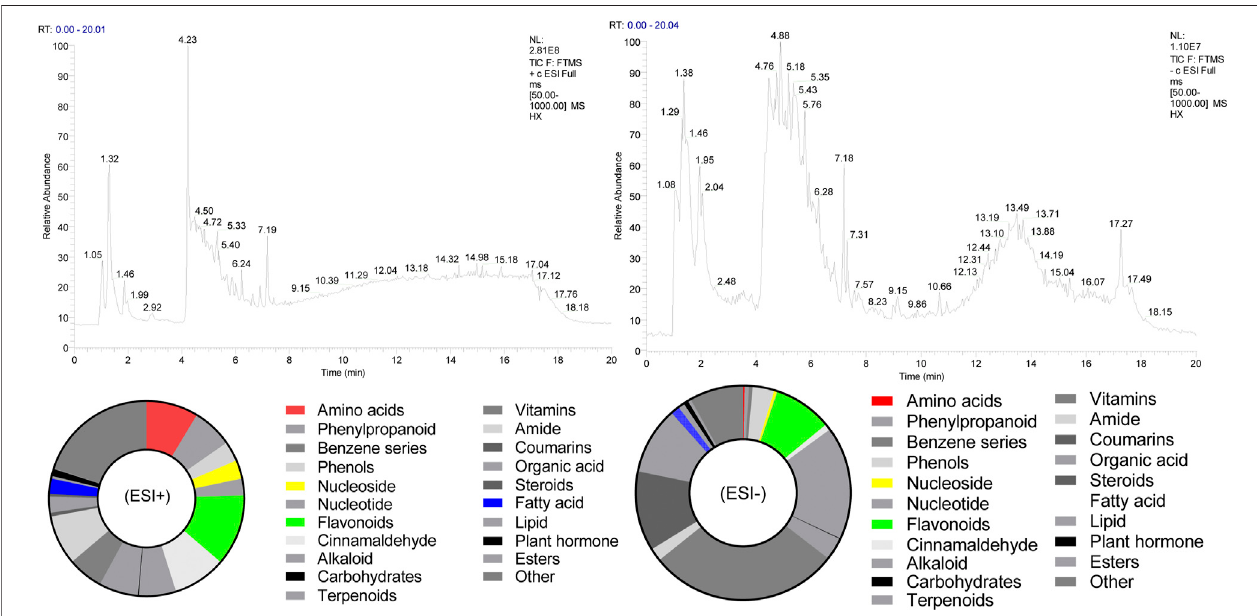
FIGURE 1 | Total ion chromatogram of HX. (ESI+) represents the positive ion detection mode, in which the mass analyzer scans only positively charged ions and fi lters out negatively charged ions. This allows us to obtain positively charged ion information during the detection process; (ESI-) denotes the negative ion detection mode,inwhichthemassanalyzerscansonlynegativelychargedionsand fi ltersoutpositivelychargedions,thusobtaininginformationregardingnegativelychargedions.